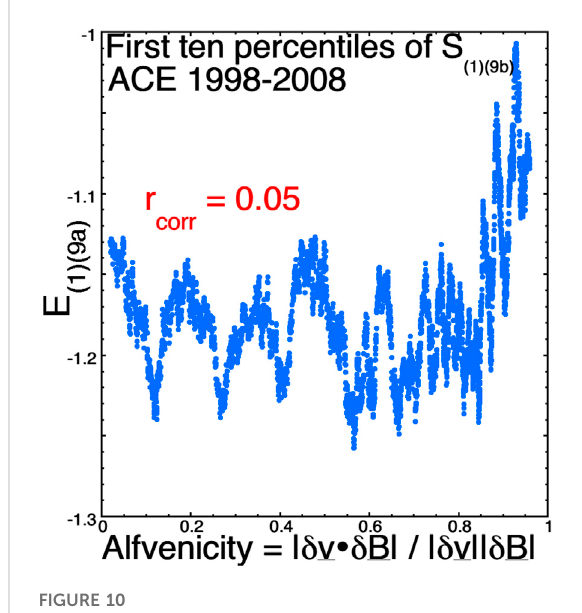
FIGURE 10 Fortimeswhenthesolar-windcompositedriverS (1)(9b) isinits lowest 10% of values, 101-point running averages of the Earth index E (1)(9a) is plotted as a function of the Alfvénicity |A|.